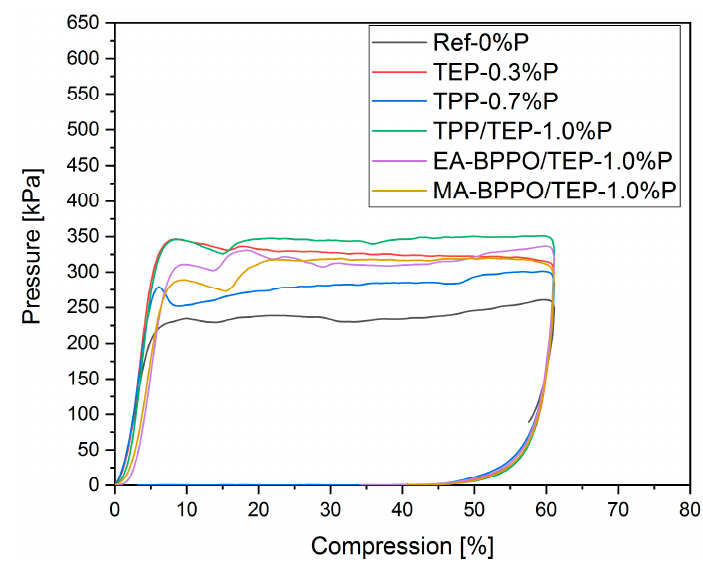
Figure 4. Pressure compression diagram of selected foams. Table 4. Mechanical properties of selected foams.